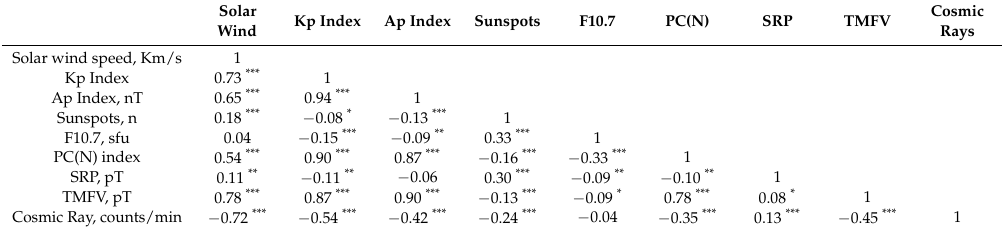
Table 3. Environmental measures—correlation